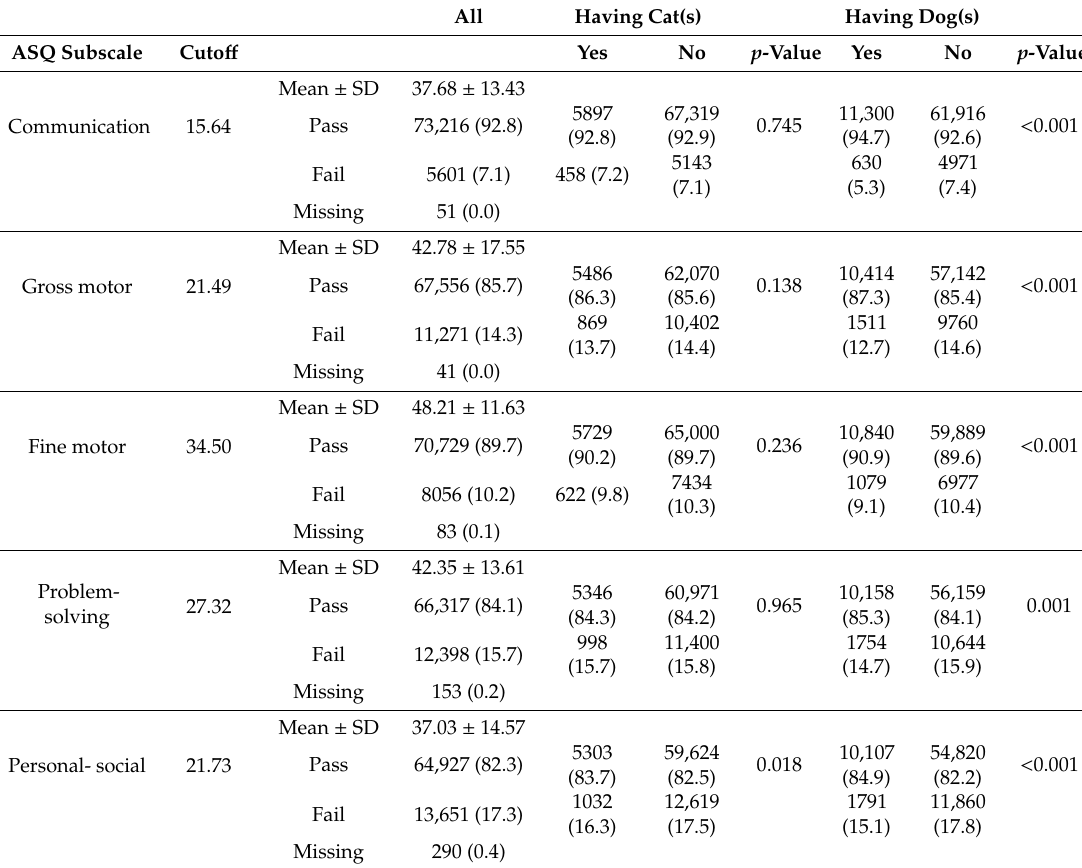
Table 2. Distribution of the ASQ-3 12-months questionnaire scores in association with having a cat and dog at six months of age.